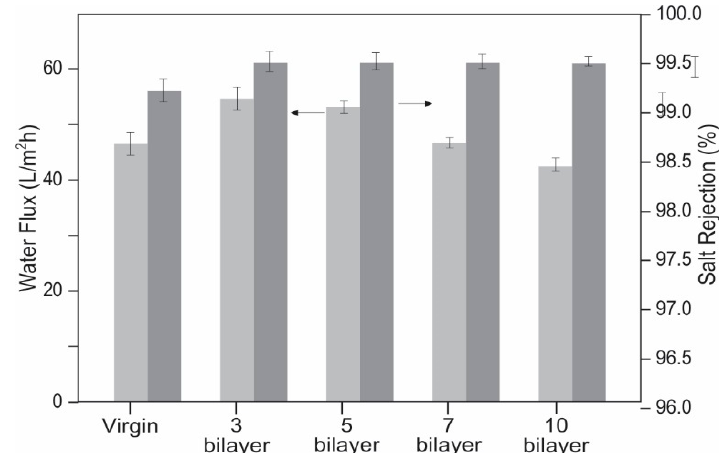
Figure 16. Normalized flux of un-coated and 3-bilayer-coated polyamide membranes, as a function of time, when exposed to solution of 100 ppm BSA in 2000 ppm NaCl. Cleaning of the membranes involved washes with deionized water only. Conditions: pH = 7.0 ± 0.2. Temperature and pressure where not provided. [268]. Reprinted with permission of Elsevier B.V. Membranes 2019 , 9 , x FOR PEER REVIEW 41 of 80